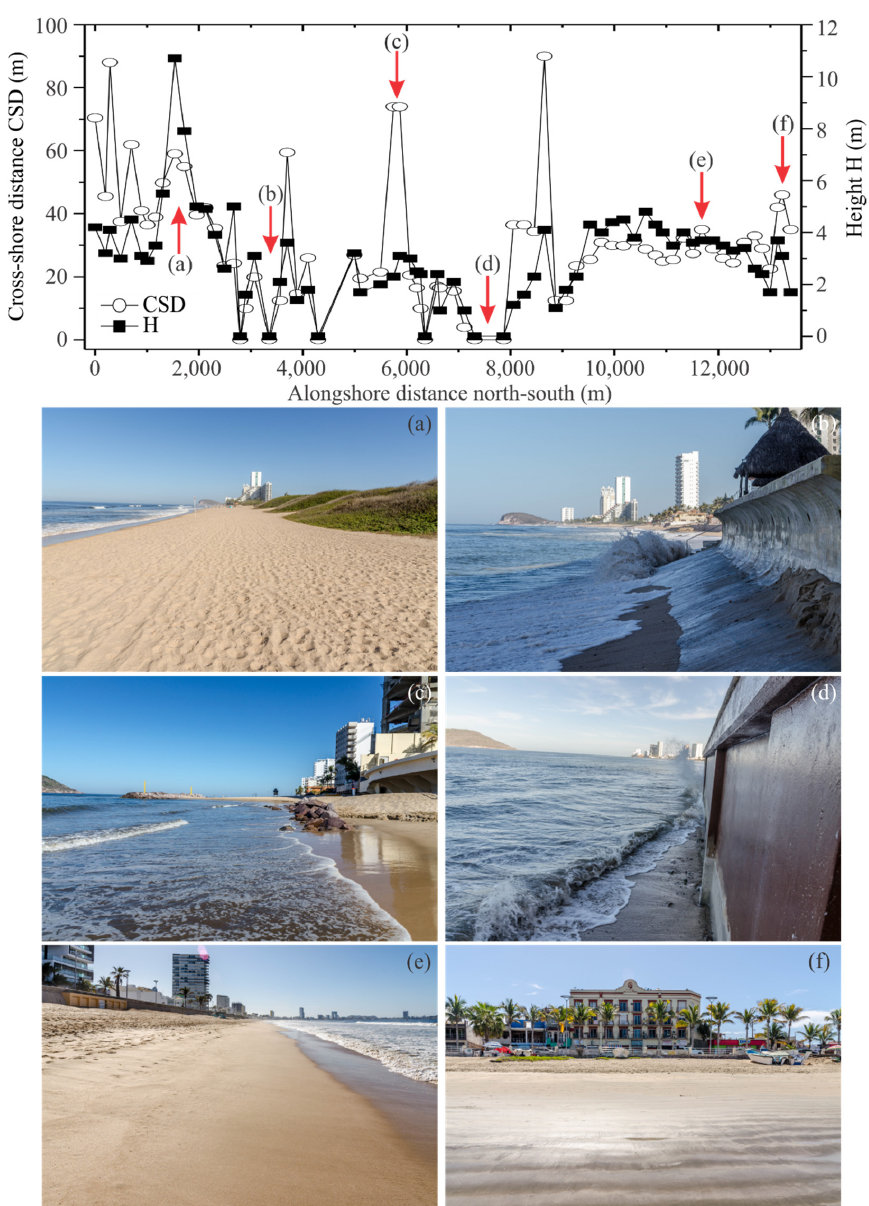
Figure 2. Field cross-shore distance and beach height along the northern section. The original conserved dune ( a ), seafront hotels with a hydrodynamic protective seawall ( b ), breakwater ( c ), vertical wall ( d ), and the concrete oceanfront corridor ( e , f ).